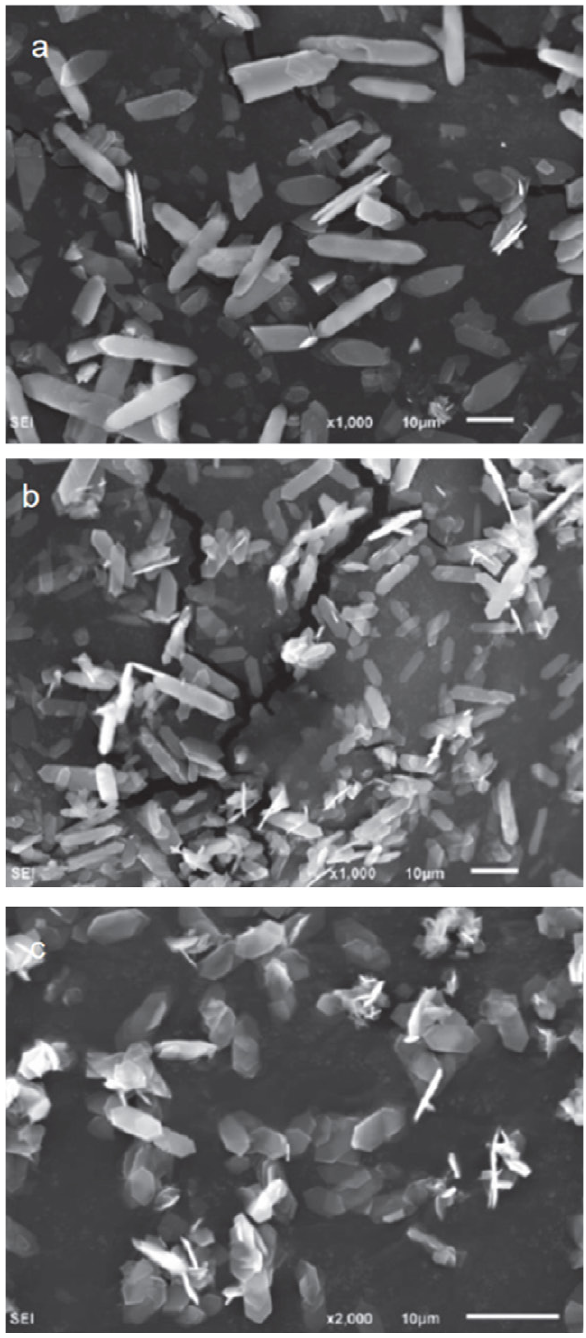
Figure 11. SEM images of different reaction stages of cerium car- bonate crystals: (a) 10 min, (b) 30 min, (c) 50